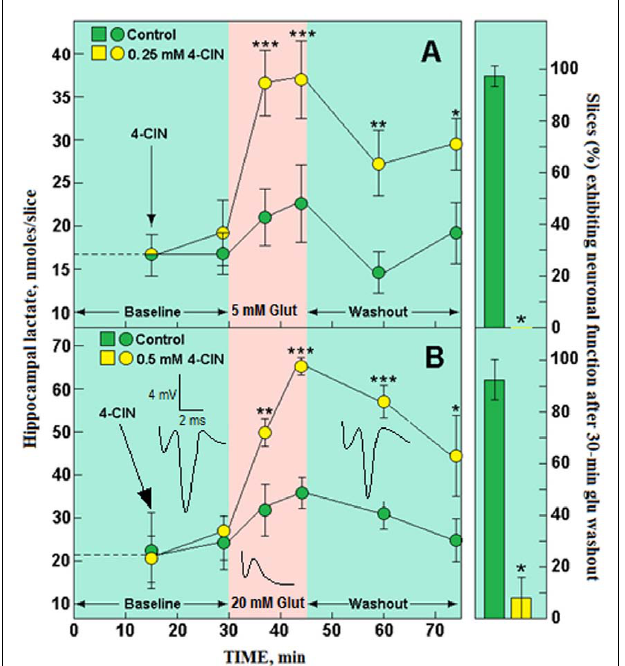
FIGURE 1 |The effect of 15min exposure to glutamate (Glut) on the ability of hippocampal slices to recover their neuronal function following a 30min Glut washout and on the content of tissue lactate at several time points during two experimental paradigms. (A) Perfusion of slices with 4mM glucose aCSF for 30min, followed by a 15min exposure to 5mM Glut, followed by a 30min washout with 4mM glucose aCSF, either in the presence of 0.25mM 4-CIN (yellow symbols) or in the absence of 4-CIN (green symbols); (B) perfusion of slices with 10mM glucose aCSF, followed by a 15min exposure to 20mM Glut, followed by a 30min washout with 10mM glucose aCSF in the presence of 0.5mM 4-CIN (yellow symbols) or in the absence of 4-CIN (green symbols). Also shown are sample traces of PS recorded from one hippocampal slice before and during exposure to 20mM Glut and after Glut washout. Each data point was repeated three times (30–36 slices over all). Bars are means ± SD; significantly different from control (* p < 0.003; ** p < 0.01; *** p < 0.004). For additional methodological details see Schurr et al.,